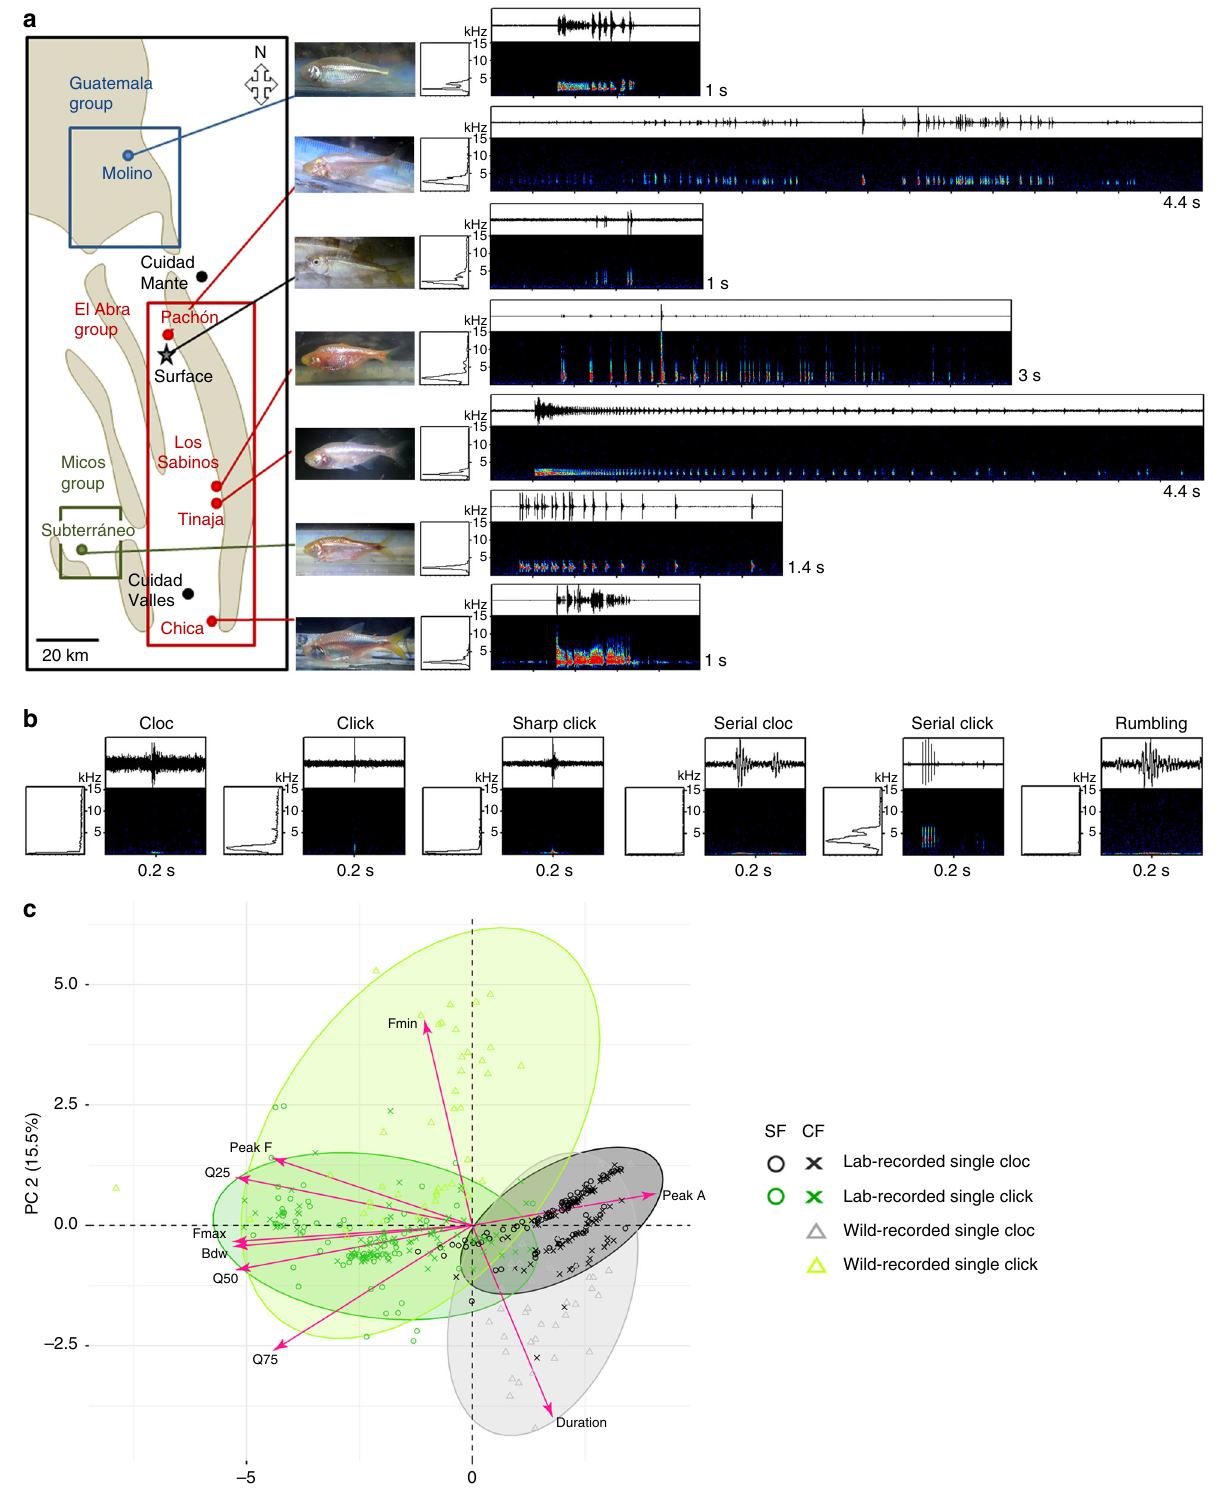
Fig. 2 A. mexicanus is a sonic species in the wild. a Recordings in the wild. A schematic map shows the 3 proposed groups of independently evolved cave- dwelling A. mexicanus populations (blue, red, green rectangles). For each location sampled, a representative specimen photographed after recording (all pictures from authors), and a sonogram of a Serial Click-like sound are shown. See also Supplementary Audios 7 – 13. b Recordings from wild Pachón fi sh, showing the 6 types of sounds previously identi fi ed in laboratory conditions, here produced in the natural environment. See also Supplementary Audios 14 – 19. c Principal component analysis (PCA) on acoustic parameters of lab- and wild-recorded simple sounds of SF and Pachón CF (Variance ± SD for PC1 is 5.3 ± 2. and for PC2 is 1.4 ± 1.2). See also Supplementary Table 1 for the statistics of the PCA analysis. Bdw, bandwidth; Fmin and Fmax, minimum and maximum frequency; Peak A , peak amplitude; Q25, 50, 75, quartiles 25, 50 and 75. Source data are provided as a Source Data fi